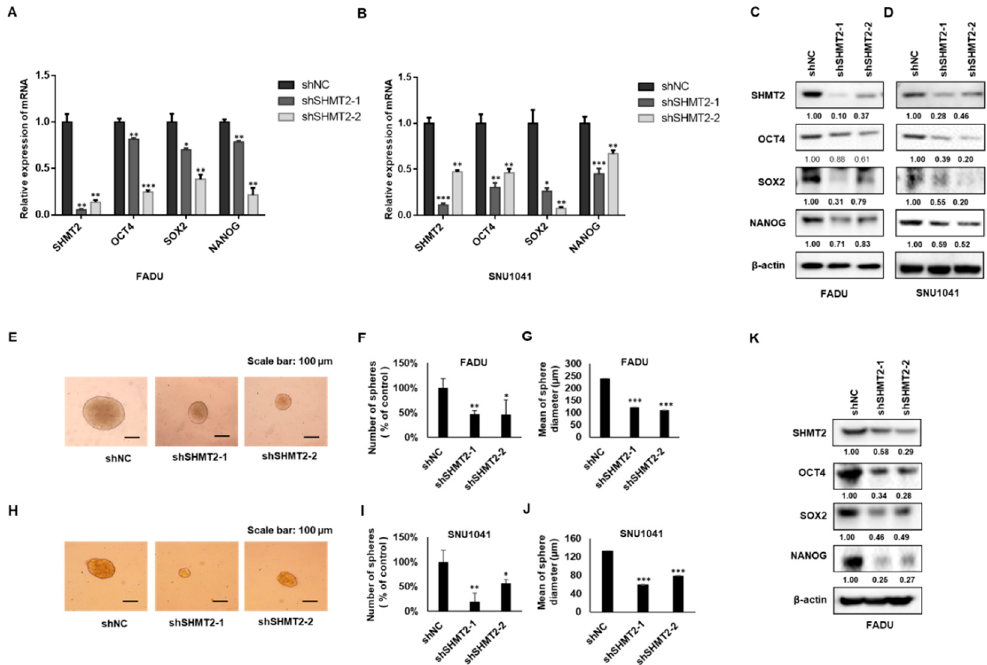
Figure 4. Silencing SHMT2 attenuated stemness properties in FADU and SNU1041 cells. ( A , B ) Compared with the control group, SHMT2 mRNA expression was significantly decreased in the sh SHMT2 -transfected FADU and SNU1041 cells; the mRNA expression of OCT4, SOX2 , and NANOG was also significantly decreased after silencing SHMT2. ( C , D ) The protein expression of OCT4, SOX2, and NANOG was also significantly decreased in sh SHMT2 -transfected FADU and SNU1041 cells. ( E ) Representative images of tumor spheres in shNC- and shSHMT2-transfected FADU cells (scale bar: 100 μ m). ( F ) A comparison of the number of spheres between shNC and sh SHMT2 -transfected FADU cells. Spheres were counted after 10 days of incubation. The sphere number of each group was normalized to the shNC group. ( G ) Comparison of sphere diameters. ( H ) Representative images of tumor spheres in shNC- and shSHMT2-transfected SNU1041 cells (scale bar: 100 μ m). ( I ) Comparison of the number of spheres between the shNC and sh SHMT2 - transfected SNU1041 cells. The sphere number of each group was normalized to the shNC group. ( J ) Comparison of sphere diameters in SNU1041 cells. ( K ) The protein expression of OCT4, SOX2,